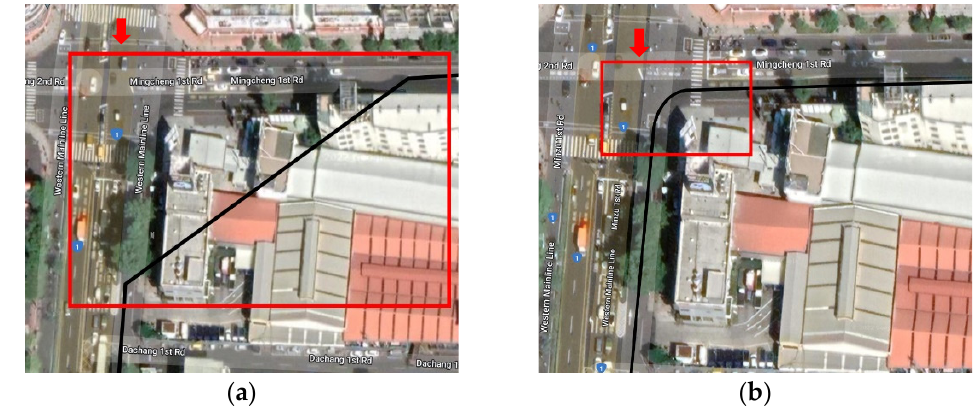
Figure 30. GPS sampling rate test (vehicle speed of 40 km/h): ( a ) 5 s sampling interval; ( b ) 1 s sampling interval.